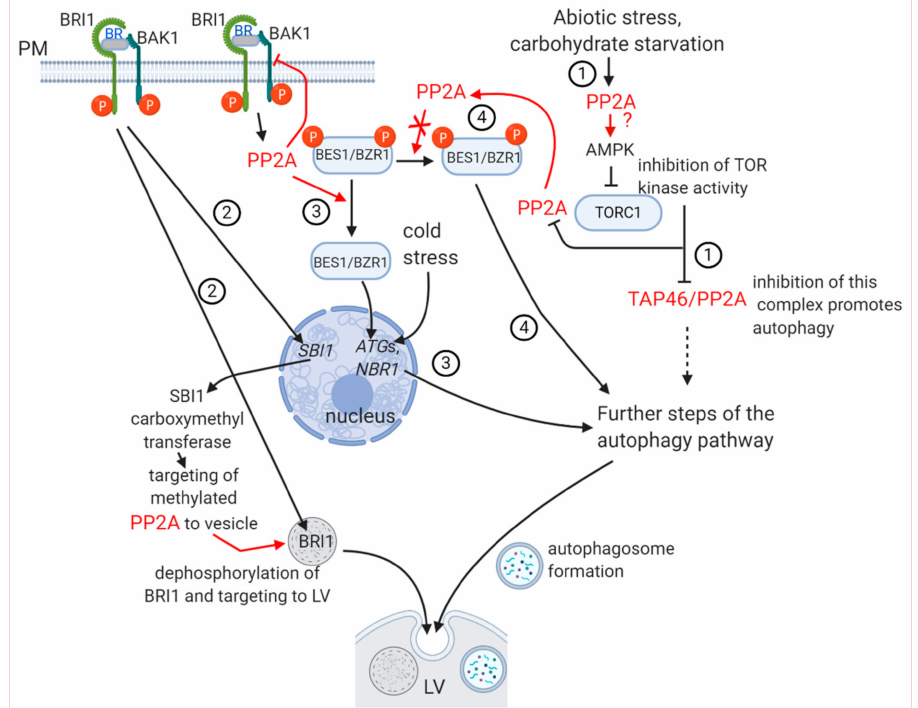
Figure 2. The regulation of autophagy and related brassinosteroid (BR) signaling pathways by PP2A. PP2A involvement is shown by red characters/arrows. TORC has various subcellular localizations in plants. We concentrate on autophagic pathways, therefore do not present here the whole signaling pathways mediated by blocking of TOR kinase signaling and by BR. Different pathways are indicated by numbers. Pathway 1: the autophagy pathway induced by inhibition of TOR kinase. The PP2A–AMPK relationship is still uncertain in plants, this is shown by a question mark. Pathway 2: induction of SBI1 methylase to remove excess BRI1. Pathway 3: induction of autophagy genes by activated BES1/BZR1, a result of BR signaling. Pathway 4: targeting of inactive BES1/BZR1 to the autophagy pathway. More details can be found in text. The upper/right part of the figure shows that during carbohydrate starvation, PP2A can be both activated and inhibited (Pathways 1 vs. 4). This may depend on the cell type dependent variation of (B and/or A) regulatory subunits. AMPK—AMP activated kinase; BR—brassinosteroid; BRI1 and BAK 1 is the BR receptor complex; LV—lytic vacuole, PM—plasma membrane. Figure was constructed with the aid of